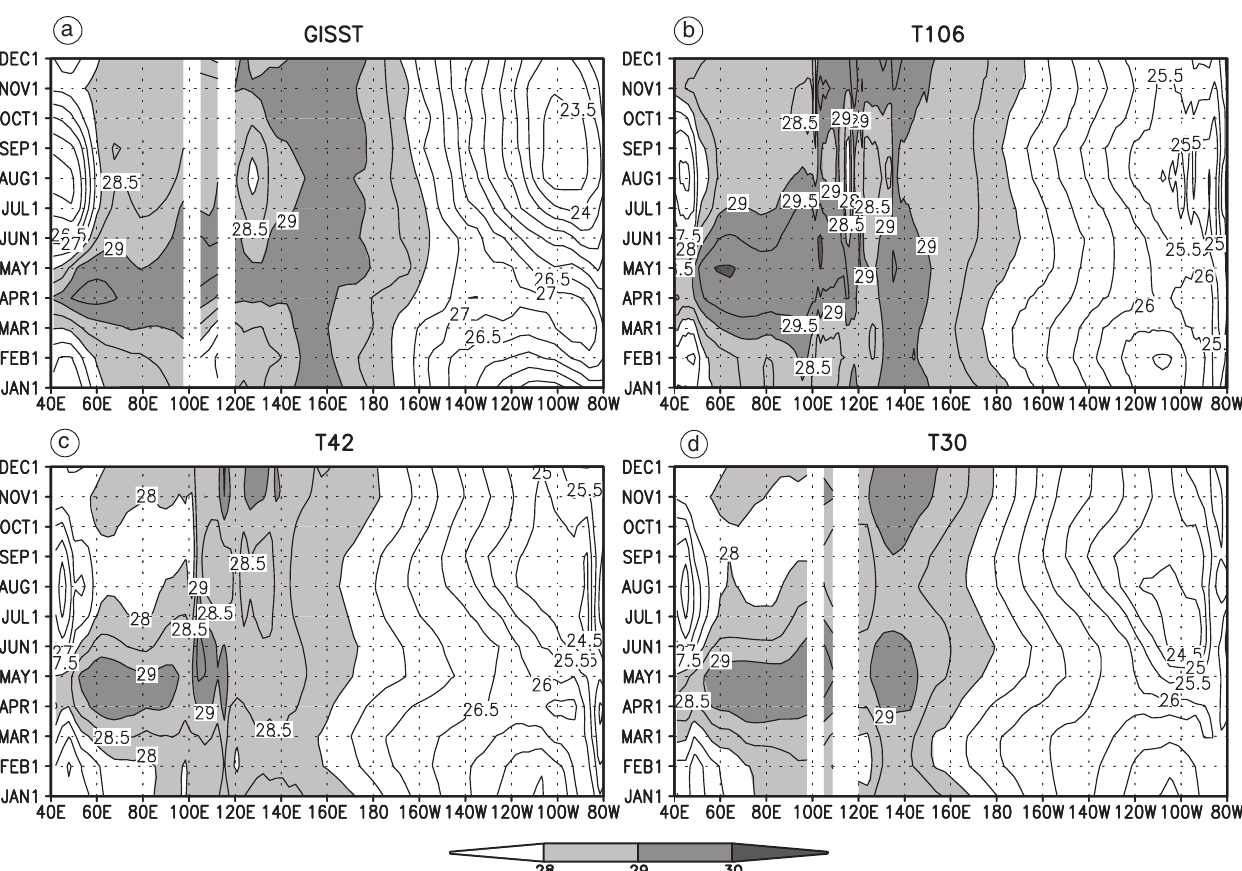
Fig. 7a-d. Seasonal cycle of the SST along the equator in the Indian Ocean and Pacific. Panel a): as derived from the GISST data set; panel b): T106 experiment; panel c): T42 experiment; panel d): T30 experiment. The vertical axis represents time, the horizontal axis longitudes. Contour line interval is 0.5 ° C. Values larger than 28 ° C are shaded; the shaded contour interval is 1 °